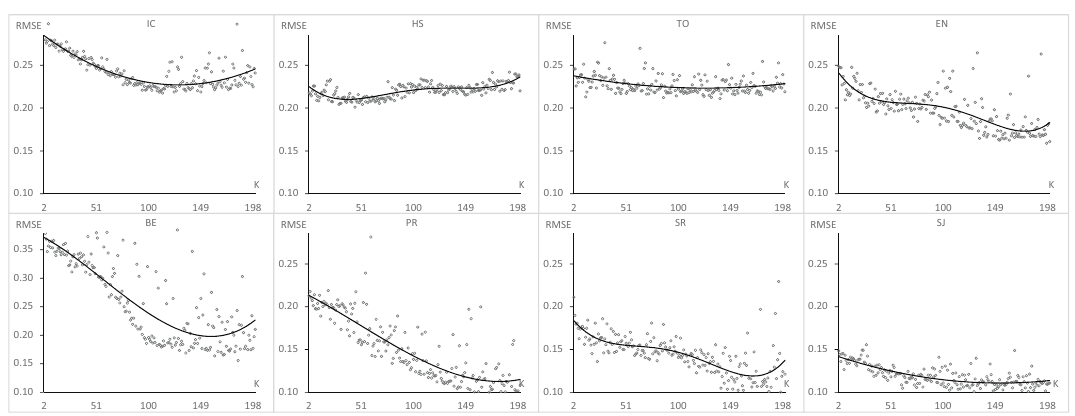
Figure 7. Optimal RMSE obtained for different values of K , where GA found the optimal pair ( β , λ ) for each one. Hence, the optimal K is such that RMSE is minimum. (cid:271)(cid:286)(cid:410)(cid:258)